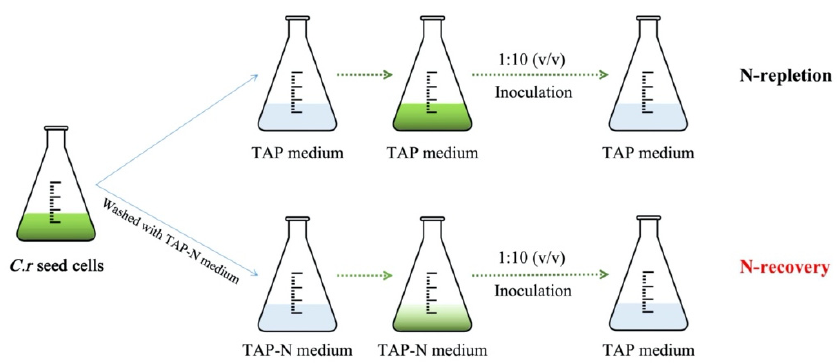
Figure 1. Schemes of two experimental conditions of C. reinhardtii as N-repletion and N-recovery. As shown in Figure 2a, the biomass accumulation under N-repletion under white light was 21.4% and 35.7% higher than that under blue and red lights, respectively, which suggested that other light wavelengths in white light were also beneficial for cell growth. Their absence in red and blue lights would limit the biomass concentration. Moreover, blue and red lights also exhibited different effects on cell enlargement and cell division. Under N-repletion, blue light increased cell weight but with a lower cell number, while red light treatment gave rise to a higher cell number but a lower cell weight as compared with white and blue lights (Figure 2b and Figure S1). This may suggest that red light was more preferable than blue light for cell division under N-repletion.